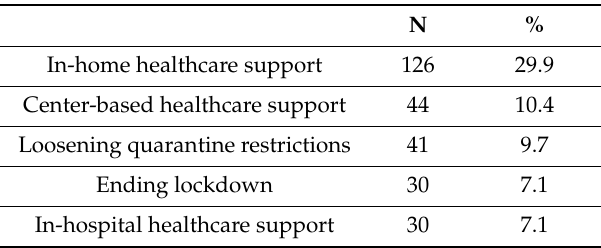
Table 5. Responses to the open-response question about what could be of help do deal with the ongoing